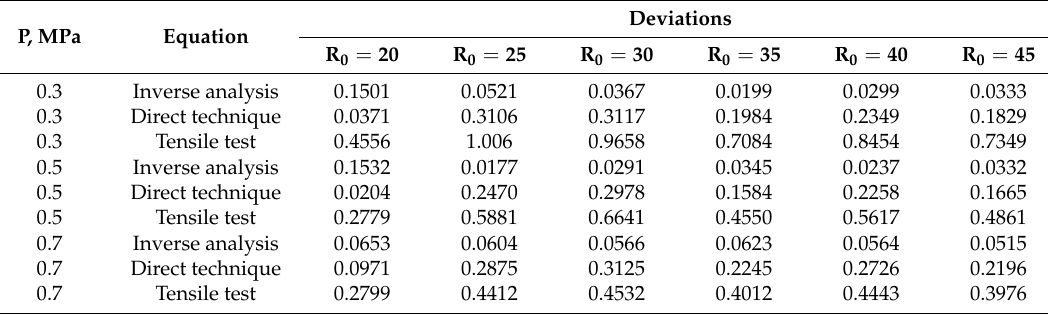
Table 3. Deviations between FE-simulations and multi-dome